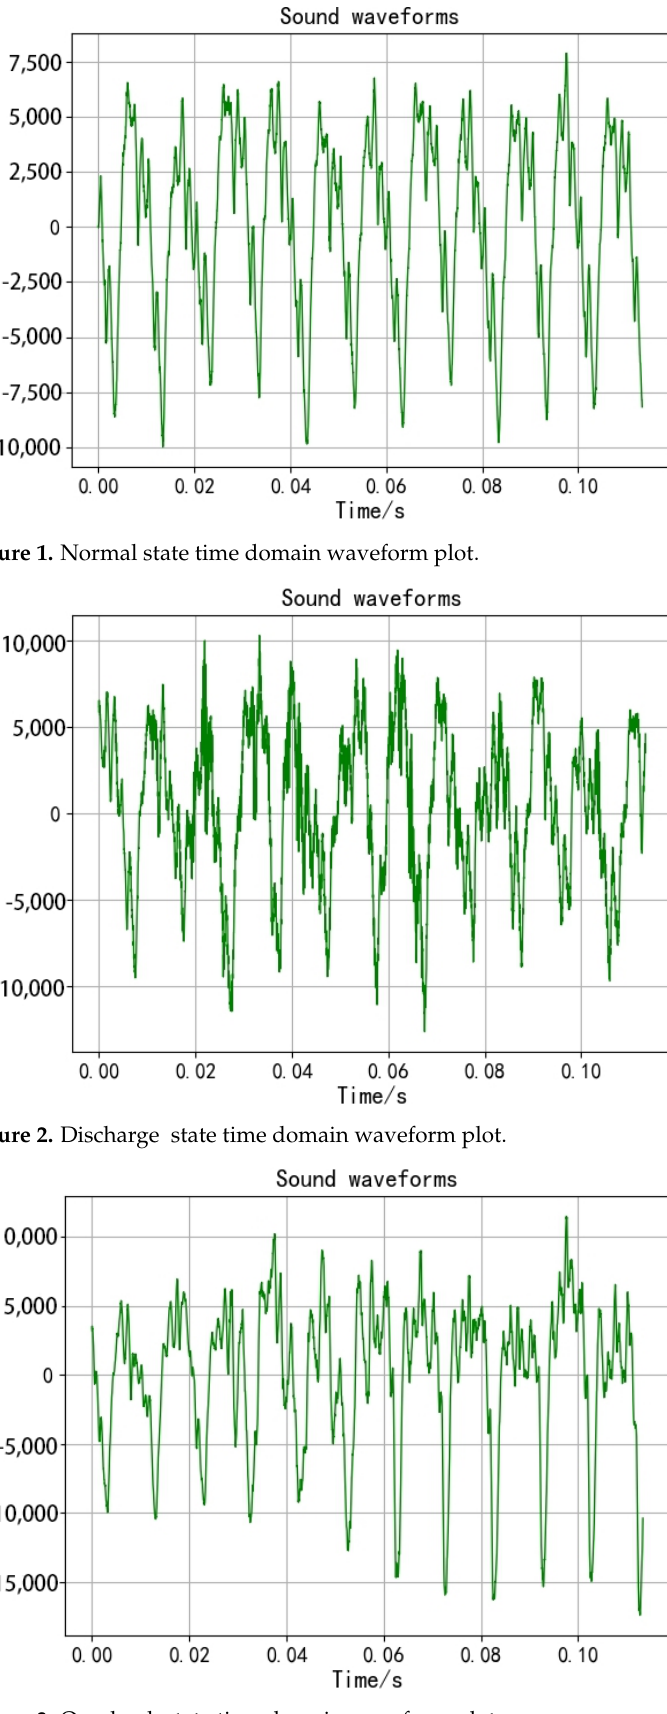
Figure 3. Overload state time domain waveform